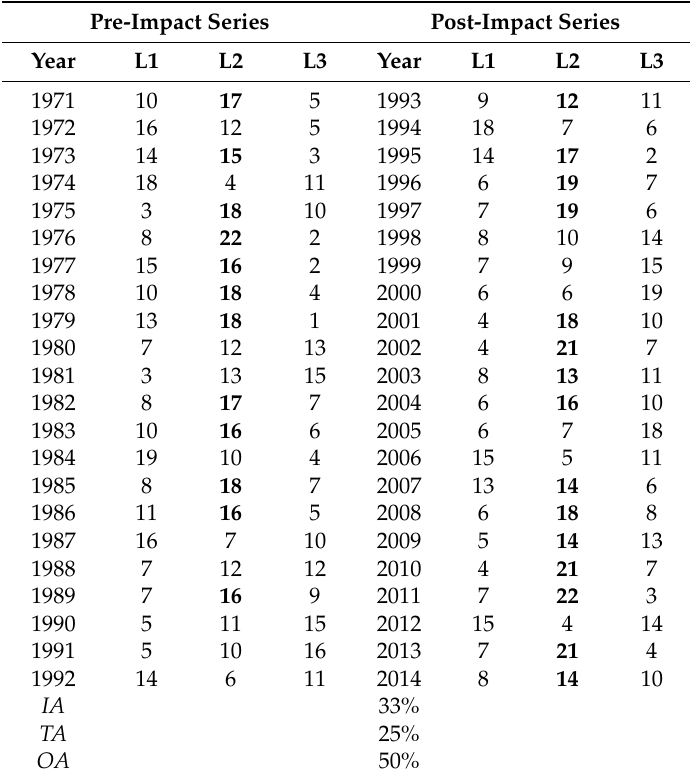
Table 2. Summary of the degree of hydrologic alteration and IHA classification information (bold text indicates that the FOCI value in interval L2 is higher than those in the other two